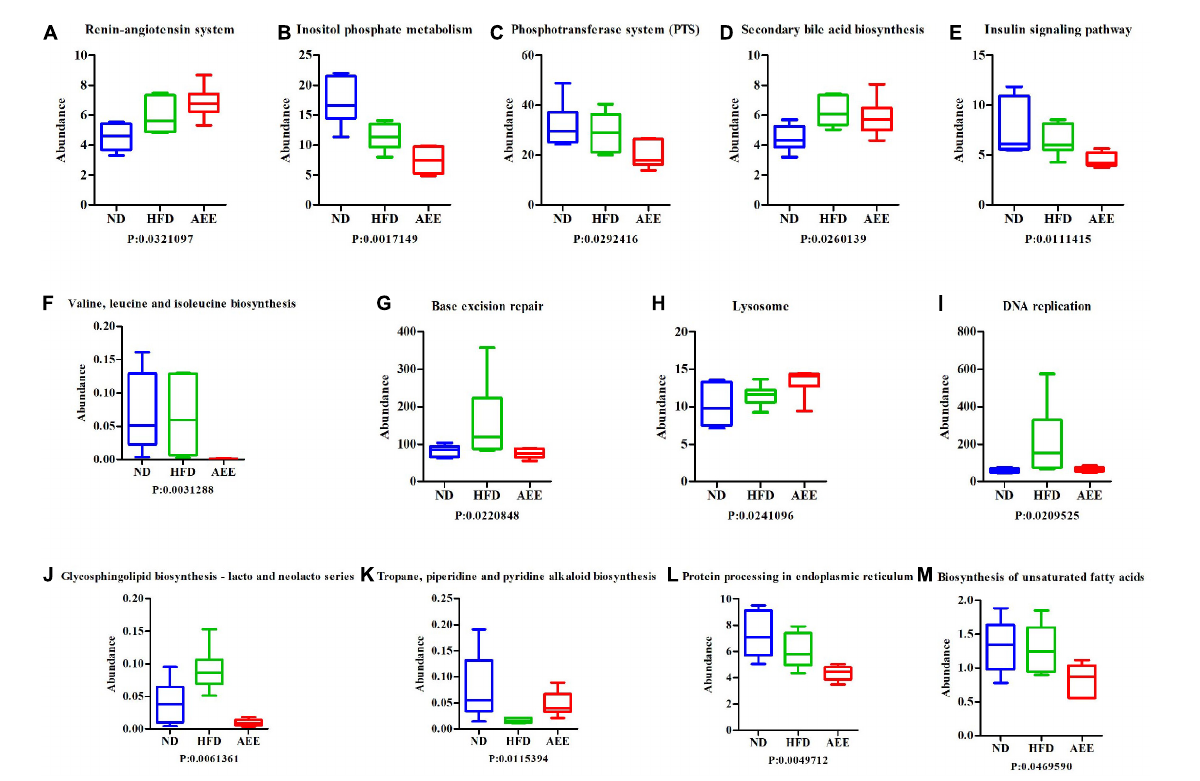
FIGURE11 The significant difference functions in KEGG. (A–M) The significant difference functions in KEGG are renin-angiotensin system, inositol phosphate metabolism, phosphotransferase system, secondary bile acid biosynthesis, insulin signaling pathway, Valine, leucine and isoleucine biosynthesis, base excision repair, lysosome, DNA replication, glycosphingolipid biosynthesis, tropane, piperidine and pyridine alkaloid biosynthesis, protein processing in endoplasmic reticulum, and biosynthesis of unsaturated fatty acids. The horizontal axis is the sample grouping; Vertical is the relative abundance of the corresponding function. P < 0.05 indicated significant difference between the two groups, and P < 0.01 indicated extremely significant difference between the two